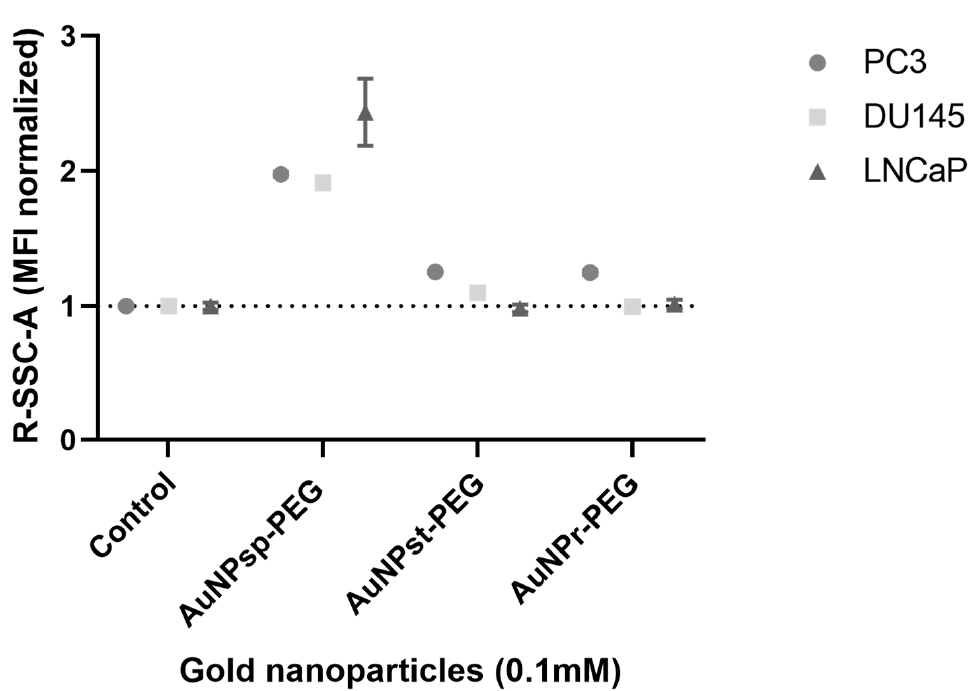
Figure 4. Cellular complexity of PC3, DU145 and LNCaP cells treated with 0.1 mM AuNPs (AuNP sp - PEG, AuNP st -PEG and AuNP r -PEG) during 24 h. The control were cells without treatment. The data was obtained with the CytExpert 2.3 software, and shown as the mean ± SD.